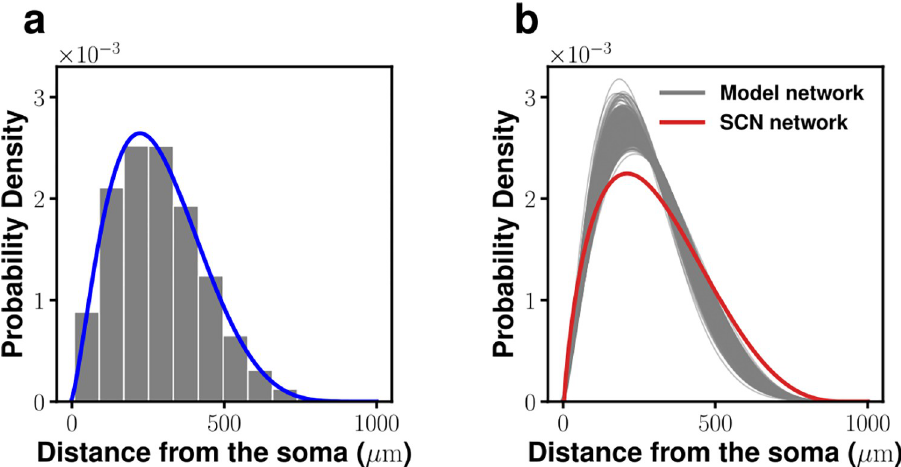
Fig 9. Postsynaptic-to-presynaptic distance pdf s. (a) One exemplary case α = 0, β = 1, c 1 = 0.125, c 2 = 0.5, c 3 = 0.375, c 4 = 0 (blue line: fit to a beta pdf ). (b) Pdf s for the qualified 482 model SCN networks (gray) and an experimentally acquired pdf (see Fig 2B).